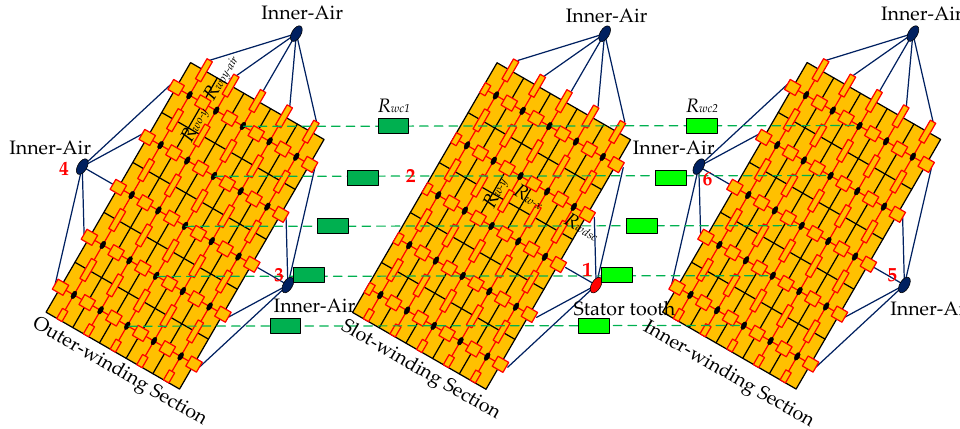
Figure 4. The thermal model of a single segmented armature winding.